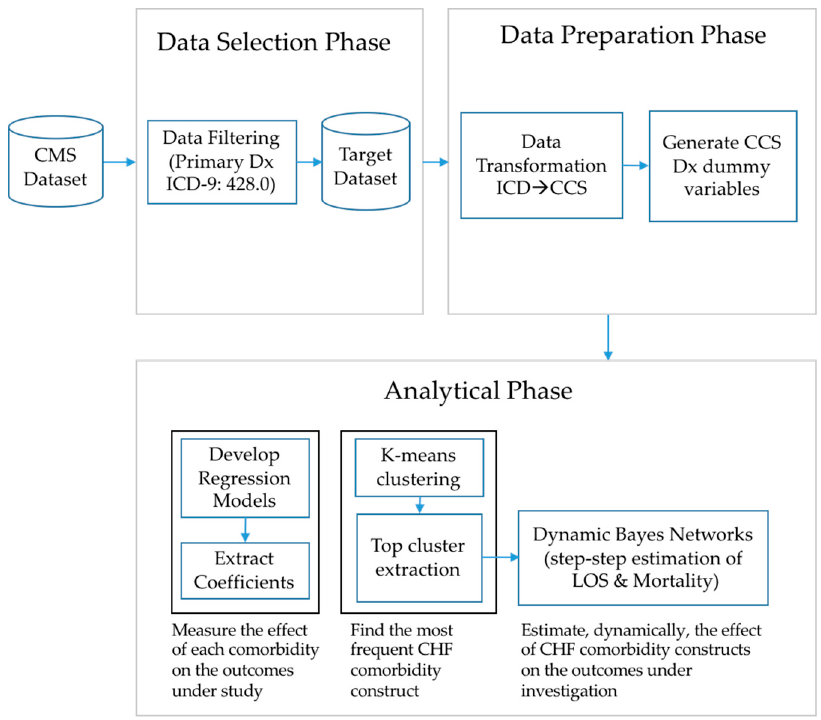
Figure 1. Overview of the study methodology.